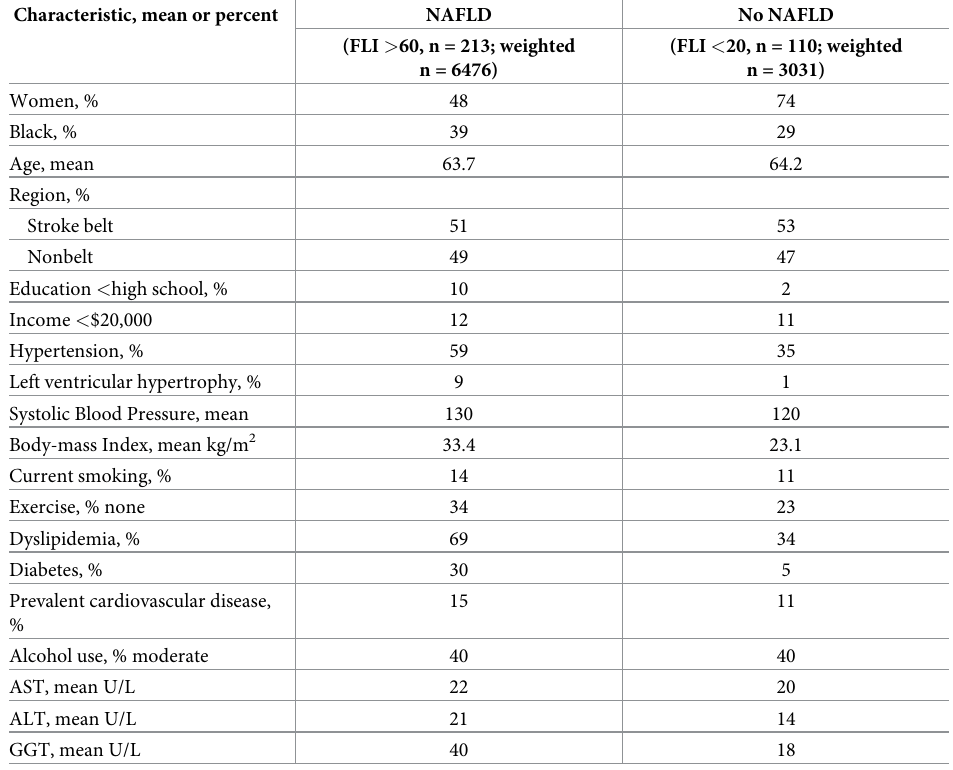
Table 1. Baseline characteristics * by NAFLD status in the control group. Characteristic, mean or percent